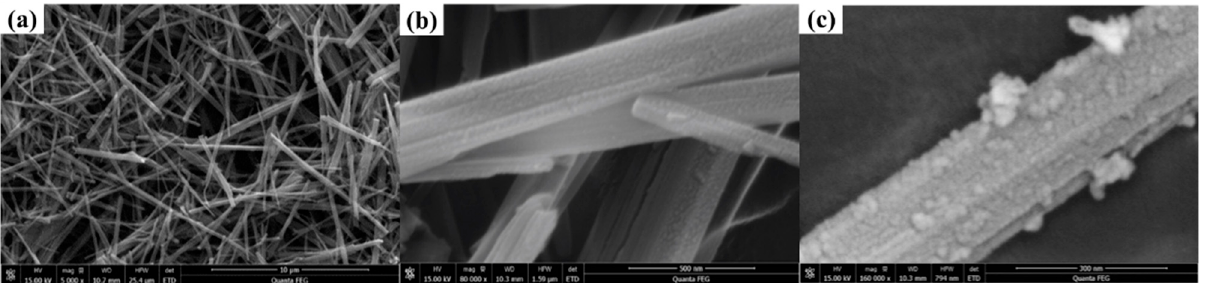
Figure 2. SEM images of ( a ) the BMCW, ( b ) SiO 2 /BMCW and ( c ) MPM.